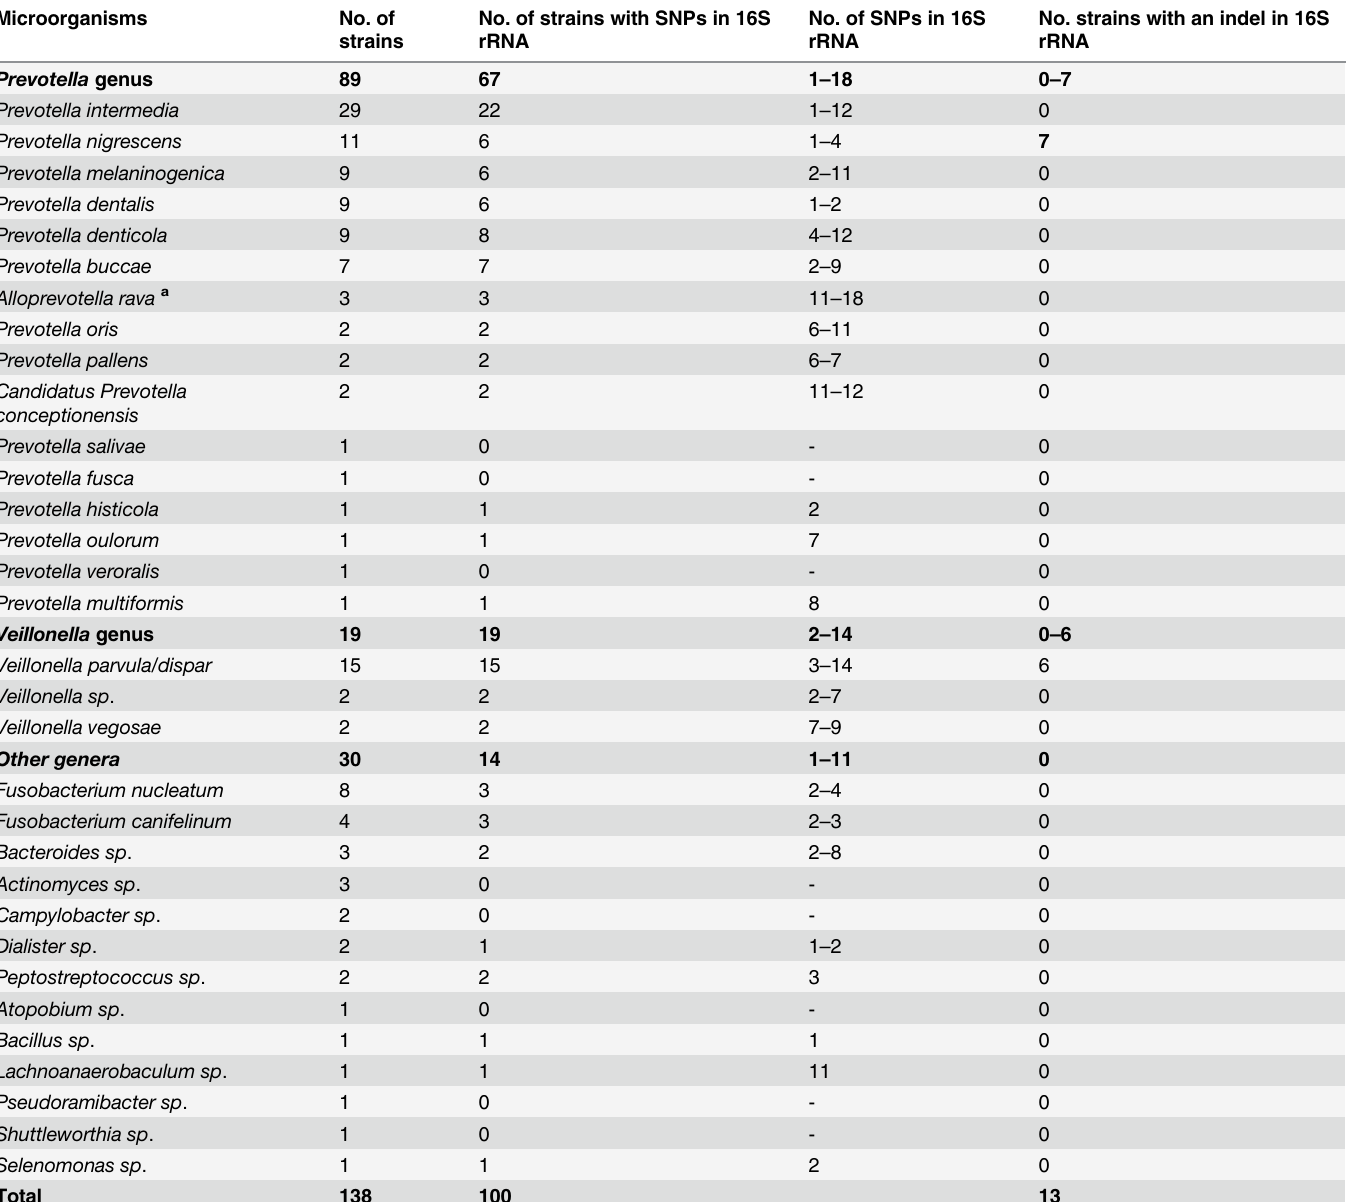
Table 2. Characteristics of intragenomic heterogeneous 16S rRNA genes in clinical anaerobic strains.